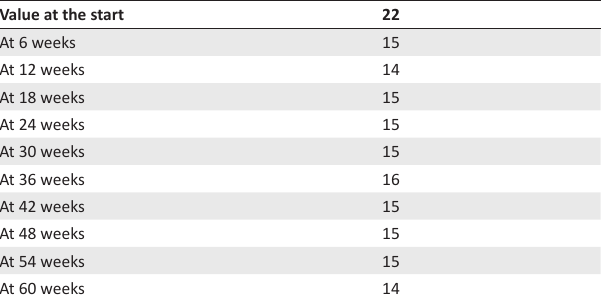
TABLE 1: Variation of the angle of trunk rotation (ATR) as measured with the Scoliometer®. Value at the start